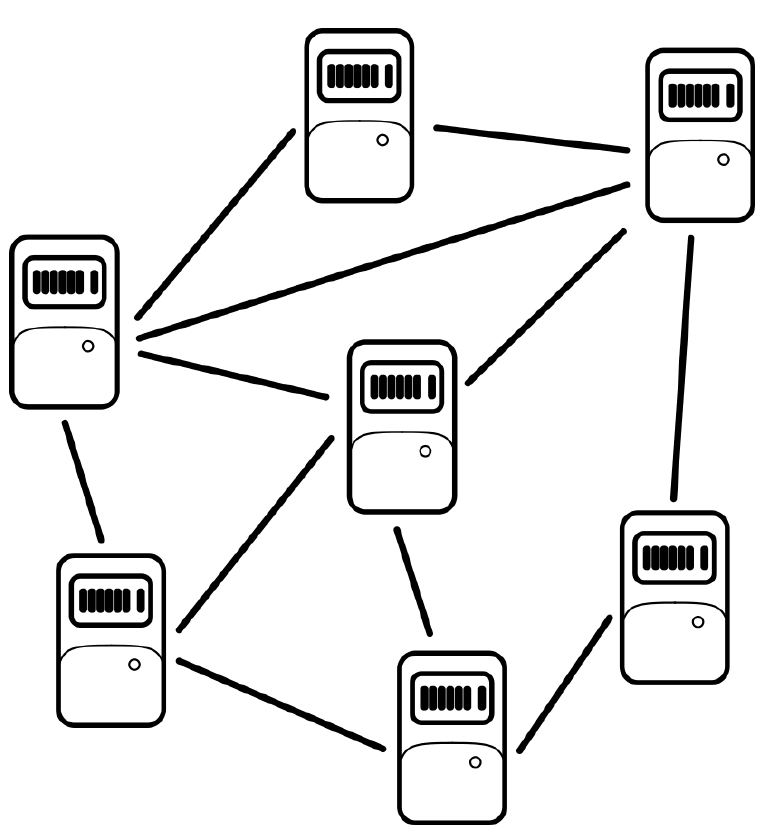
Figure 1. Nodes in a decentralized